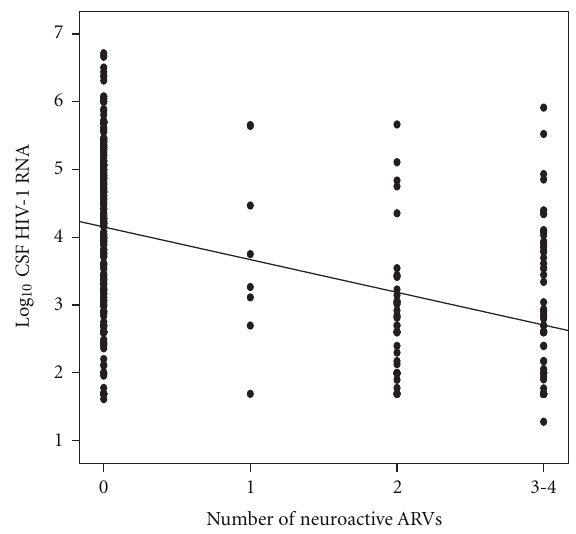
Figure 1: Correlation between the HIV-RNA load in the cere- brospinal fluid (CSF) (copies/mL) and the number of neuroactive drugs included in the HAART regimen. r = − 0 . 44, P < 0 . 001. ARVs: antiretroviral